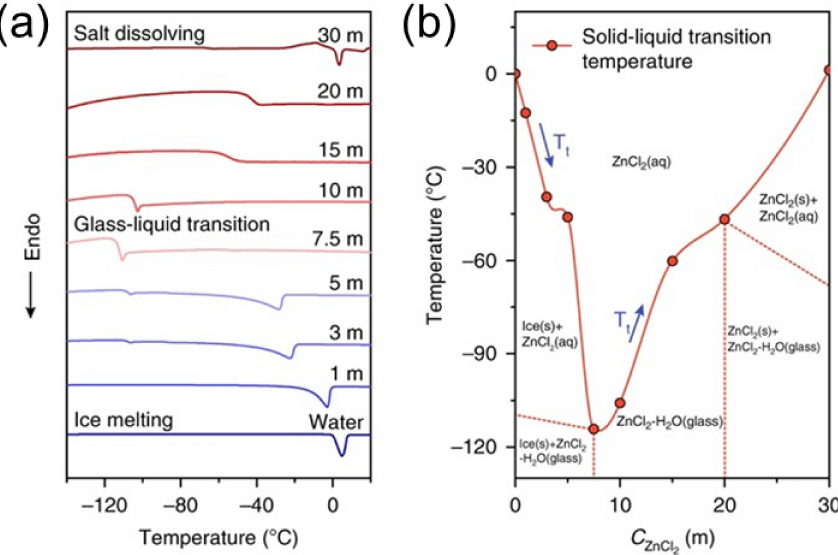
Figure 21. The properties of solid–liquid transitions and the mechanism of vitrification. Thermody- namic change and transition of different C ZnCl2 electrolytes at low temperatures. ( a ) DSC test from − 150 to 20 ◦ C at a heating rate of 5 ◦ C min − 1 . ( b ) The major Tt vs. C ZnCl2 and the phase composition of ZnCl 2 solution at different temperatures and concentrations. Reprinted with permission from Ref. [108]. Copyright 2020